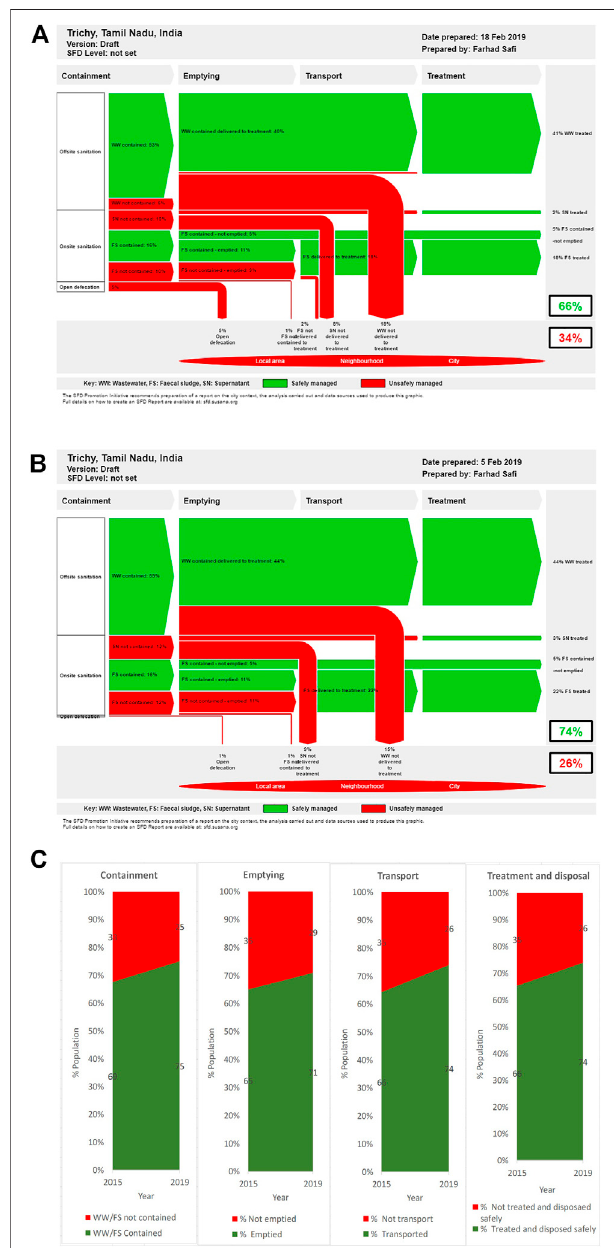
FIGURE 2 | (A) New Shit Flow Diagram (SFD) for 2015, (B) SFD for 2019, (C) Trend Graphs 2015 – 2019.